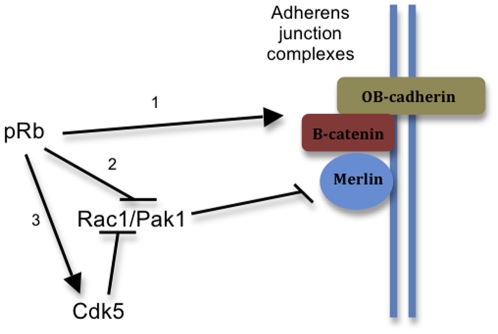
Possible mechanisms by which pRb could regulate cell adhesion.pRb regulates transcription of adherens junction and cell adhesion genes (1). pRb also regulates cell adhesion by repressing Rac1, a repression that allows merlin activation and adherens junction assembly. pRb achieves this by down-regulating the expression of Pak1 (2) or by activating Cdk5 (3). The relevance of (3) for the pRb-mediated assembly of adherens junctions is still unclear.